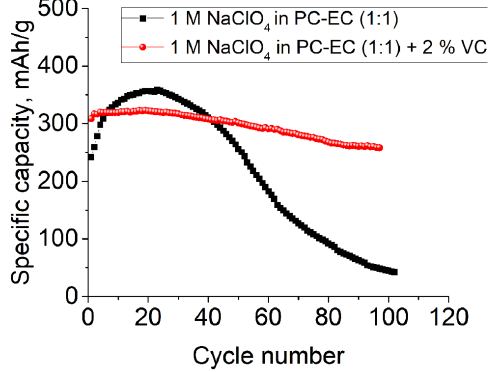
Figure 10. Change in the discharge capacity of Ge nanorods at galvanostatic cycling with a current density of 125 mA/g in VC-free electrolyte (black squares) and electrolyte with 2% VC (red circles). (Reprinted with permission from [180]. Copyright 2022, MDPI, Open Access).